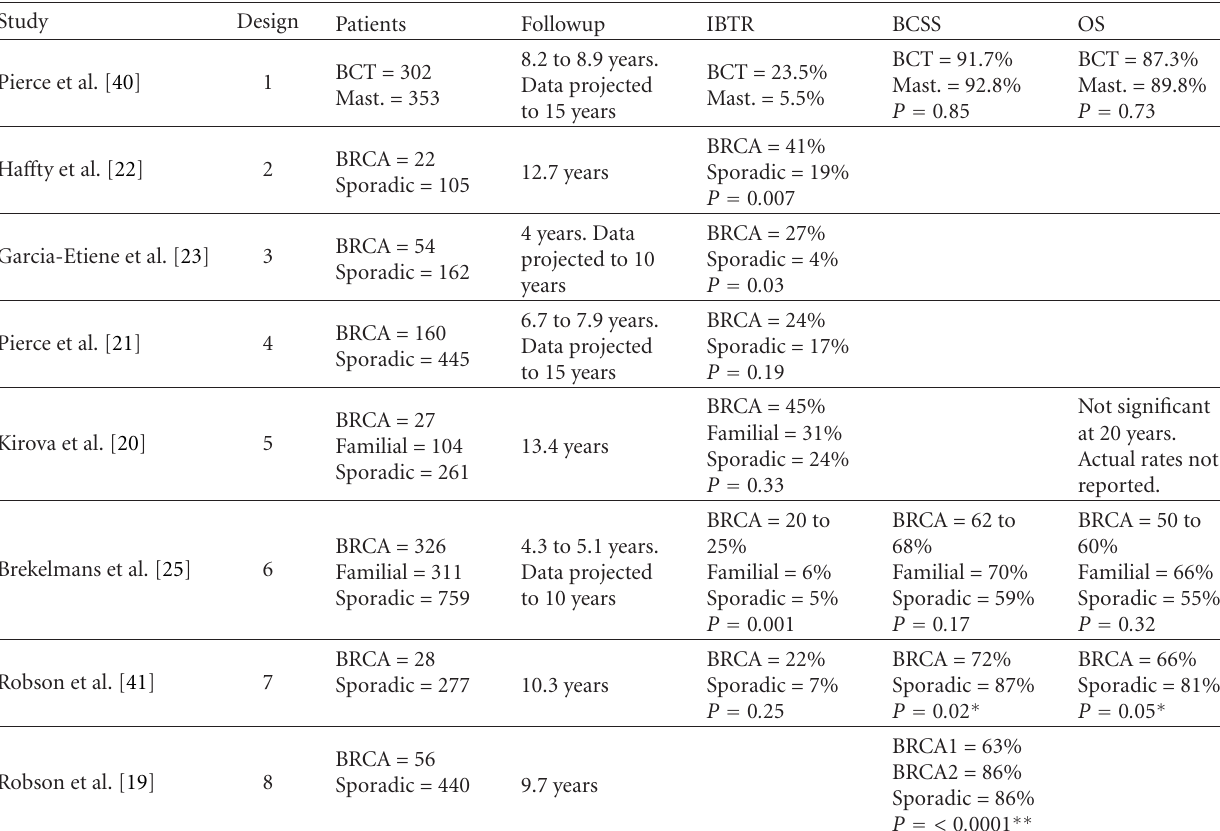
Table 1: Outcomes of a ff ected BRCA1/2 mutation